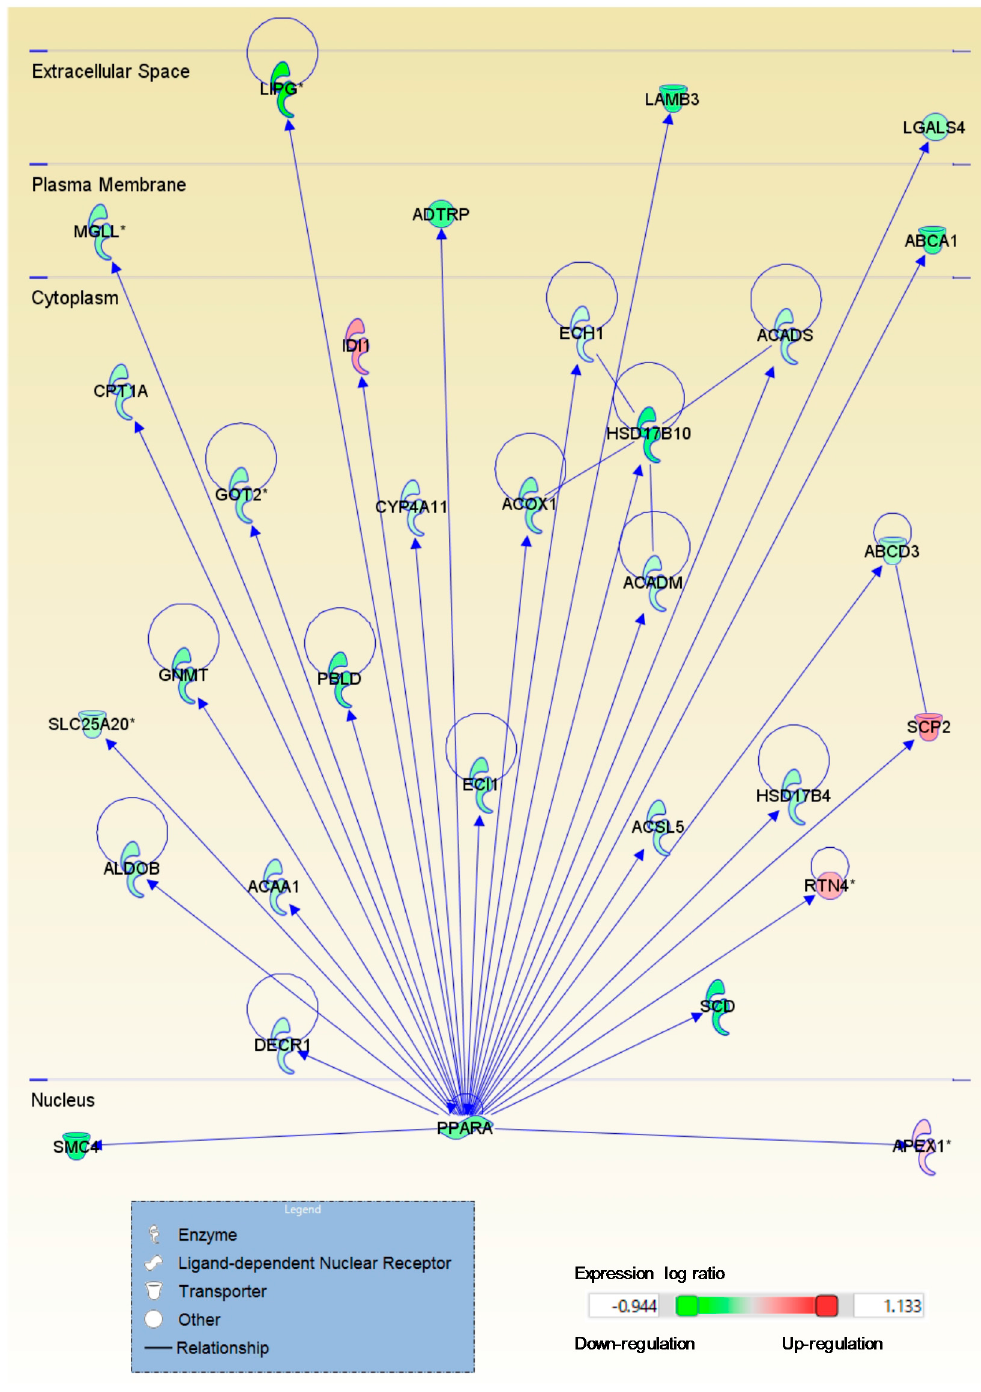
Figure 4. Astaxanthin suppressed the expression of PPARA and the target molecules in mice with nonalcoholic steatohepatitis. → , expression: —, protein-protein binding. *, More than 2 genes were included. The relationship among PPARA, which was predicted to be inhibited by astaxanthin, and the target molecules in the dataset was identified by Ingenuity Pathway Analysis.